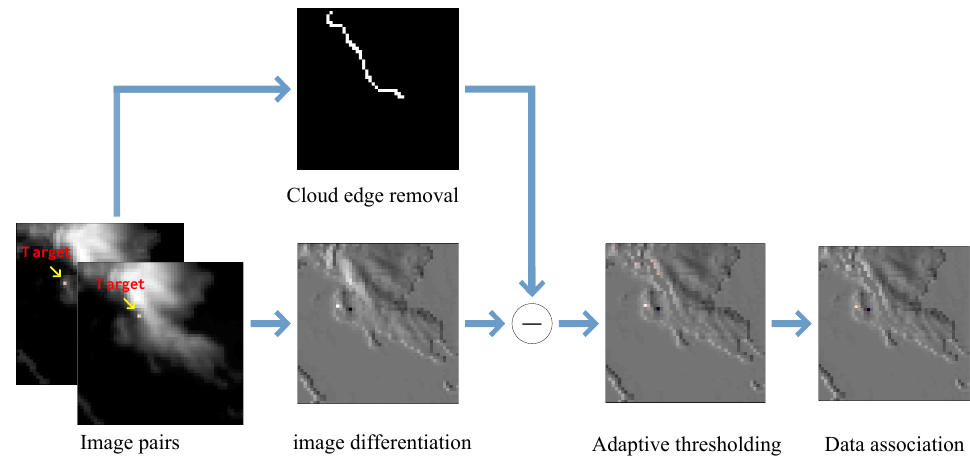
Figure 4. Overall flowchart for a double linear array